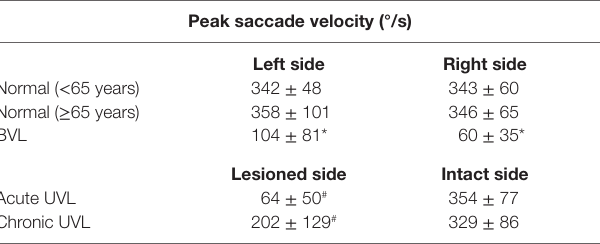
Notice the significant decrease of peak saccade velocity in BVL patients on both sides compared with that in normal subjects (* indicates significant difference in